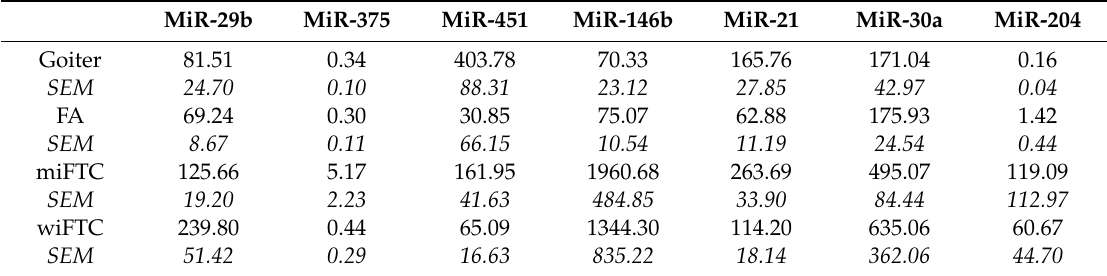
Table 2. Relative miRNA expression in various types of thyroid nodes.